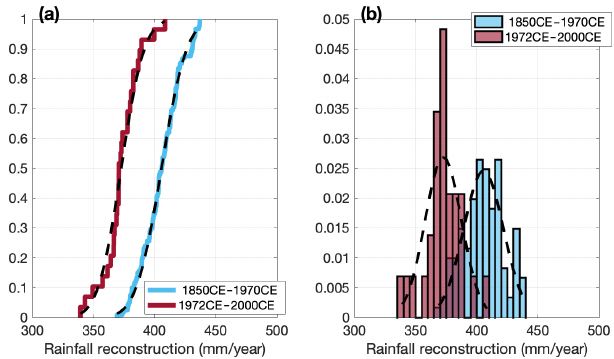
Figure 6. (a) Empirical distribution function plot for rainfall recon- struction samples from 1850 to 1970CE (blue curve) and from 1972 to 2000CE (red curve). (b) Probability density function scaling his- togram for two samples. The black dashed curves are each sample’s corresponding normal